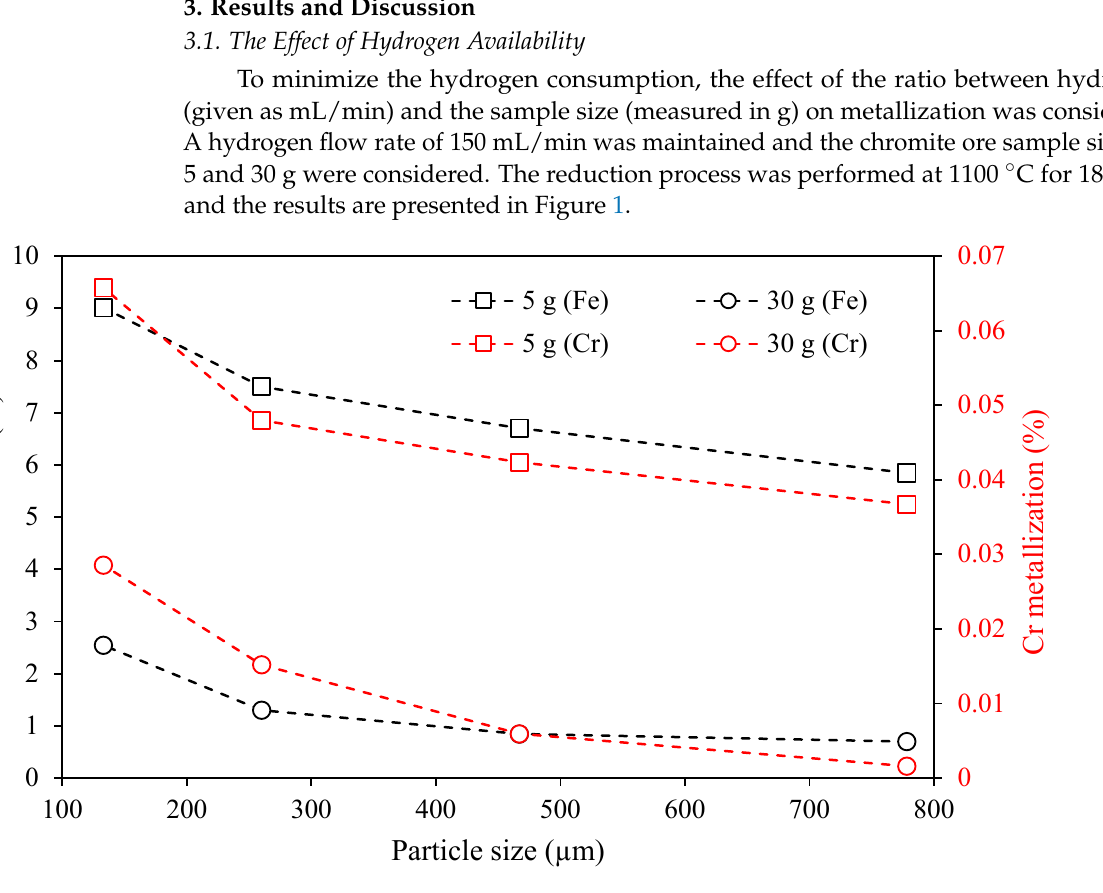
Figure 1. The effect of sample mass exposed to hydrogen on Fe and Cr metallization during reduction. Both chromite batches (5 g and 30 g) of all size-fractioned (d 90 of 133 to 778 µm) samples were reduced at 1100 °C for 180 min at a hydrogen flow rate of 150 mL/min.